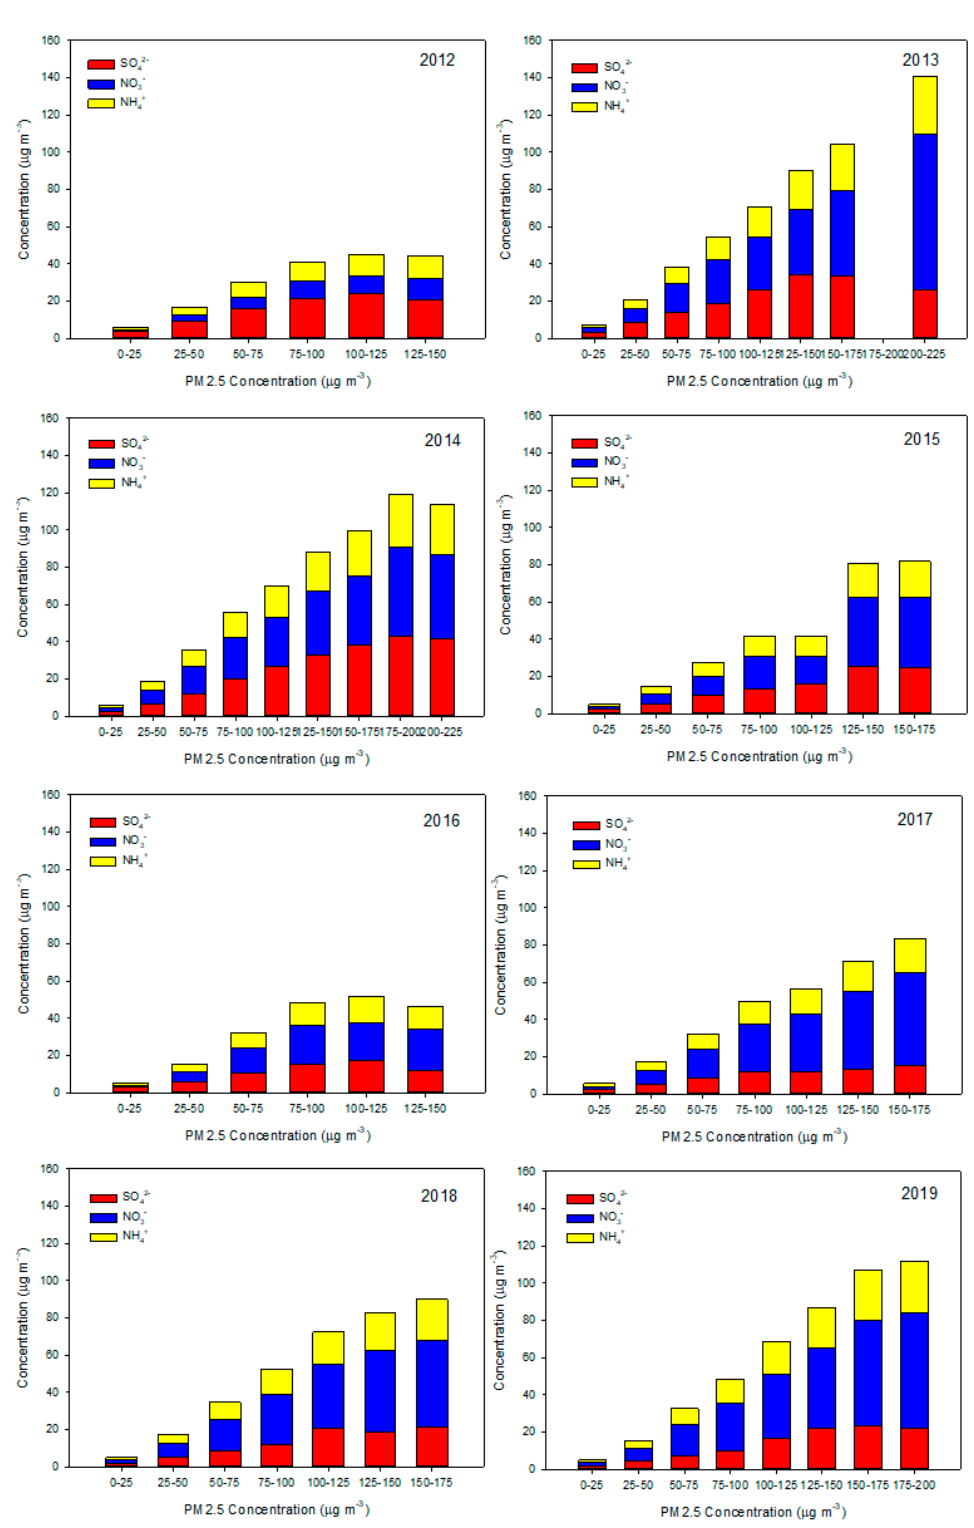
Figure 5. Changes in the concentrations of major ion components according to PM2.5 concentration in Seoul.